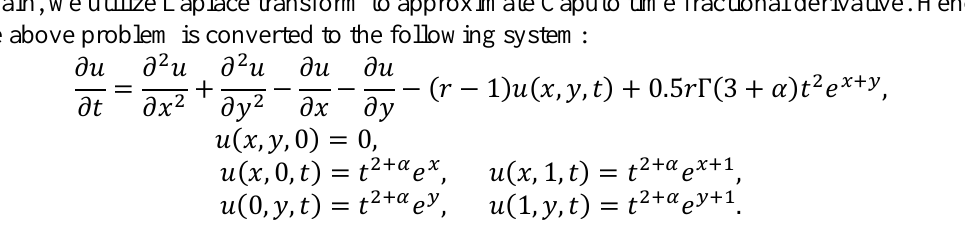
Table 3. Comparison between standard and hybrid methods at ℎ 𝑁 Method CPU time (sec) Memory usage